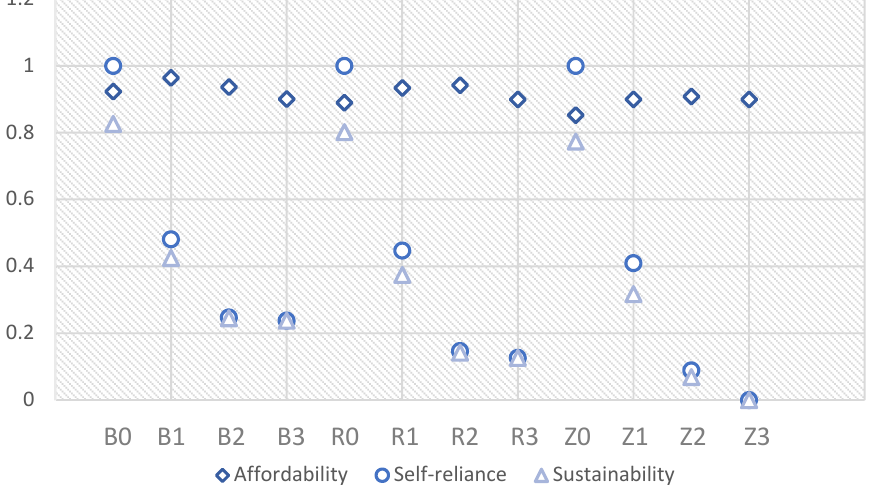
Figure 14. Dimensions of the energy transition index for all scenarios.